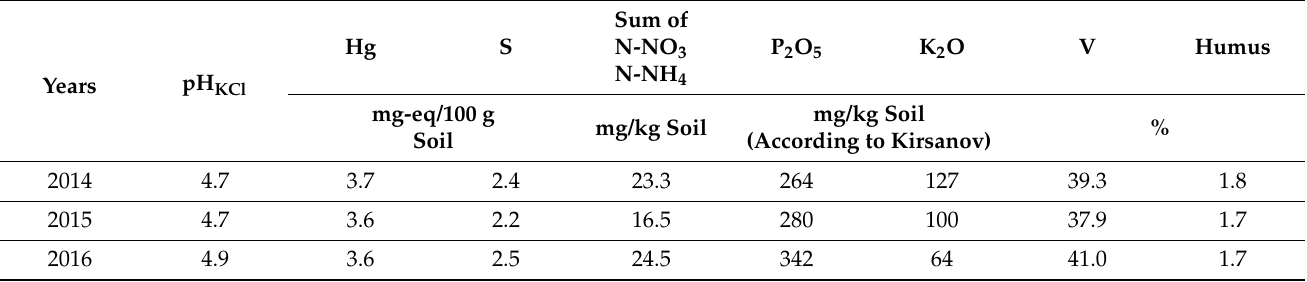
Table 1. Agrochemical characteristics of sod-slightly podzolic sandy loam soils before field trial